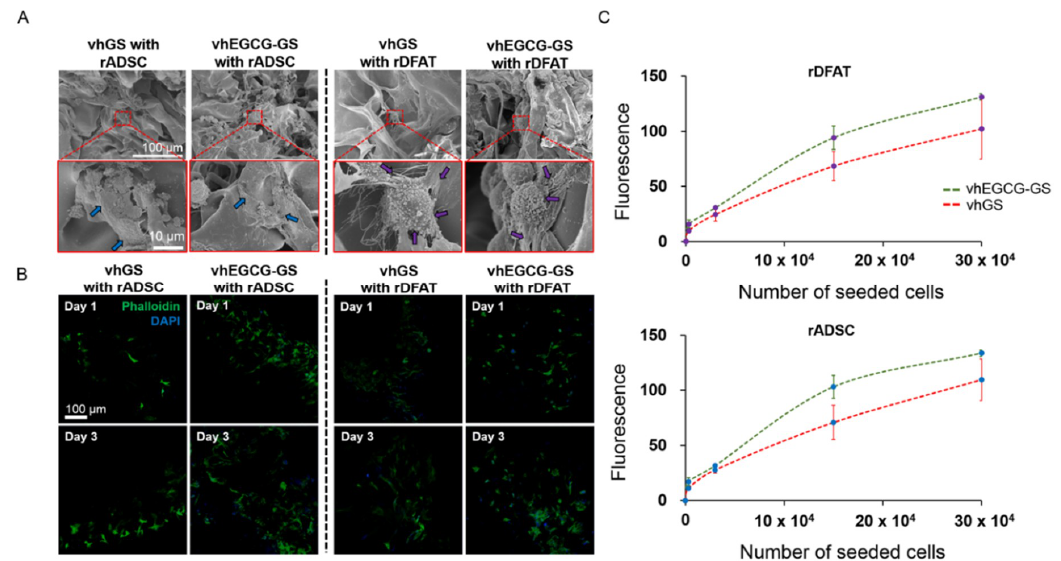
Figure 7. Cell attachment property of the sponges. ( A ) Low- and high-magnification SEM images of the cells cultured on the sponges for 24 h. Blue Arrows: rADSC; purple arrows: rDFAT cells. ( B ) Immunostaining of the cells cultured on the sponges for 1 and 3 days. Green: phalloidin staining; Blue: DAPI staining. ( C ) Semi-quantitative analysis of the cell number on the sponges evaluated with Picogreen assay at day 1. Cells were seeded at various cell densities and cultured for 24 h. y -axis: fluorescence, x -axis: seeded cell number. The dots show the mean with standard deviation ( n = 2).